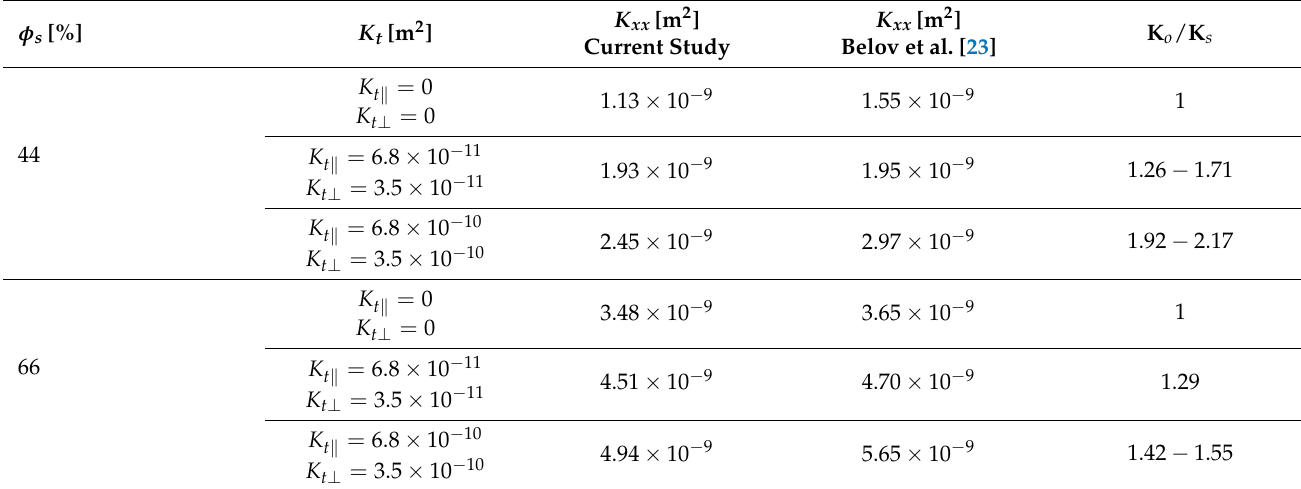
Table 3. Summary of calculated global permeability in the x -direction ( K xx ) using the developed numerical model in this study and their comparison with the results presented by Belov et al. [23]. Two different inter-tow porosities ( φ s ) were chosen with three different sets of intra-tow permeabilities ( K t (cid:107) and K t ⊥ ). K xx [m 2 ] K xx [m 2 φ s [%] K t [m 2 ]